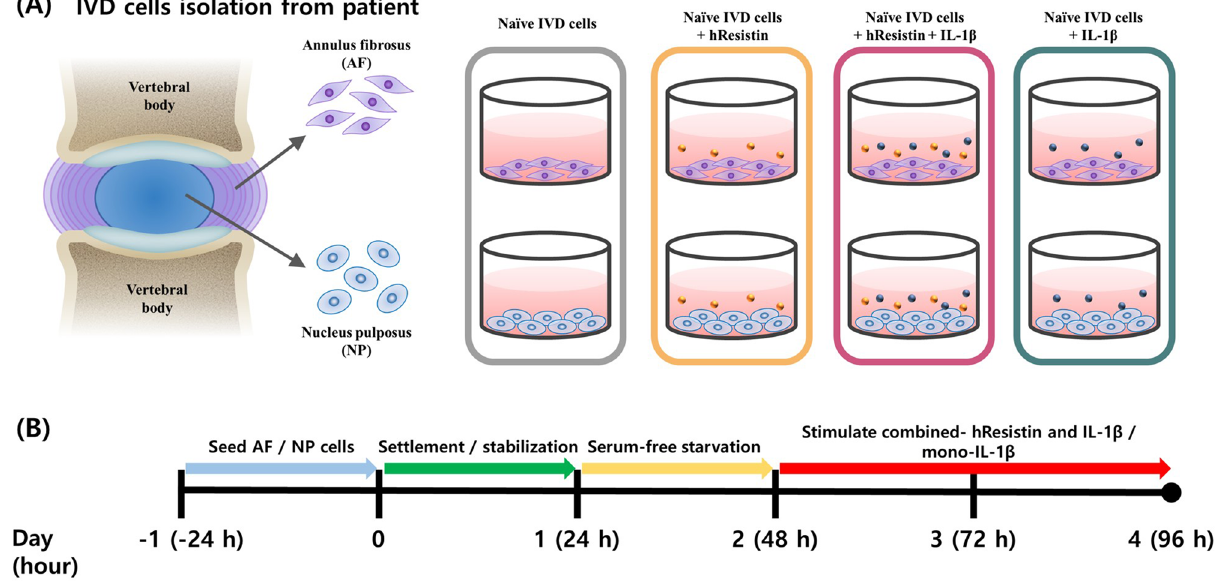
Figure 1. ( A ) Schematic design and ( B ) timeline of the experiment used for the mono-hResistin, combined- hResistin and IL-1β or mono-IL-1β stimulation of hAF and